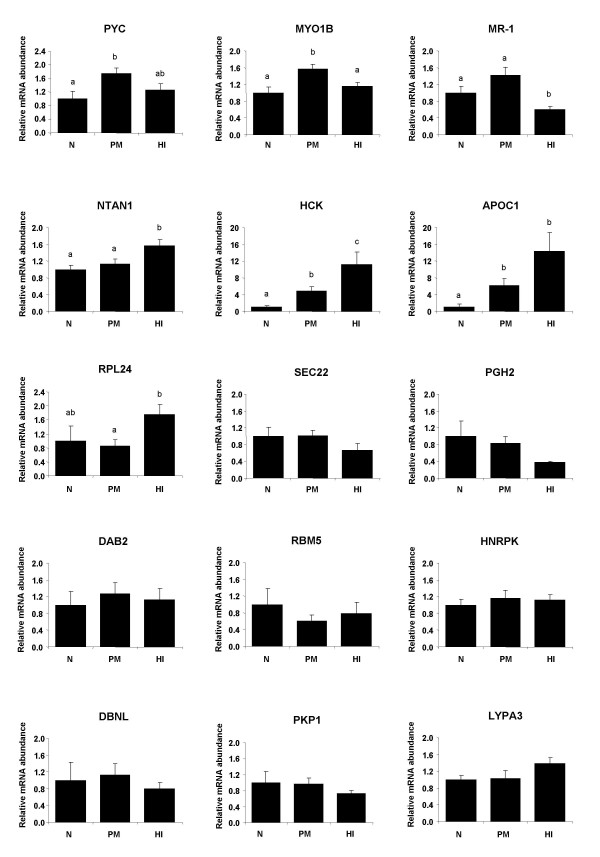
Real-time PCR analysis of gene mRNA abundance (mean ± SEM) in unfertilized eggs collected after natural ovulation (n = 4), hormonally-induced ovulation (n = 11) and photoperiod-manipulated ovulation (n = 14). Different letters indicate significant differences between groups at p < 0.05. The official human symbol is indicated for all studied genes.